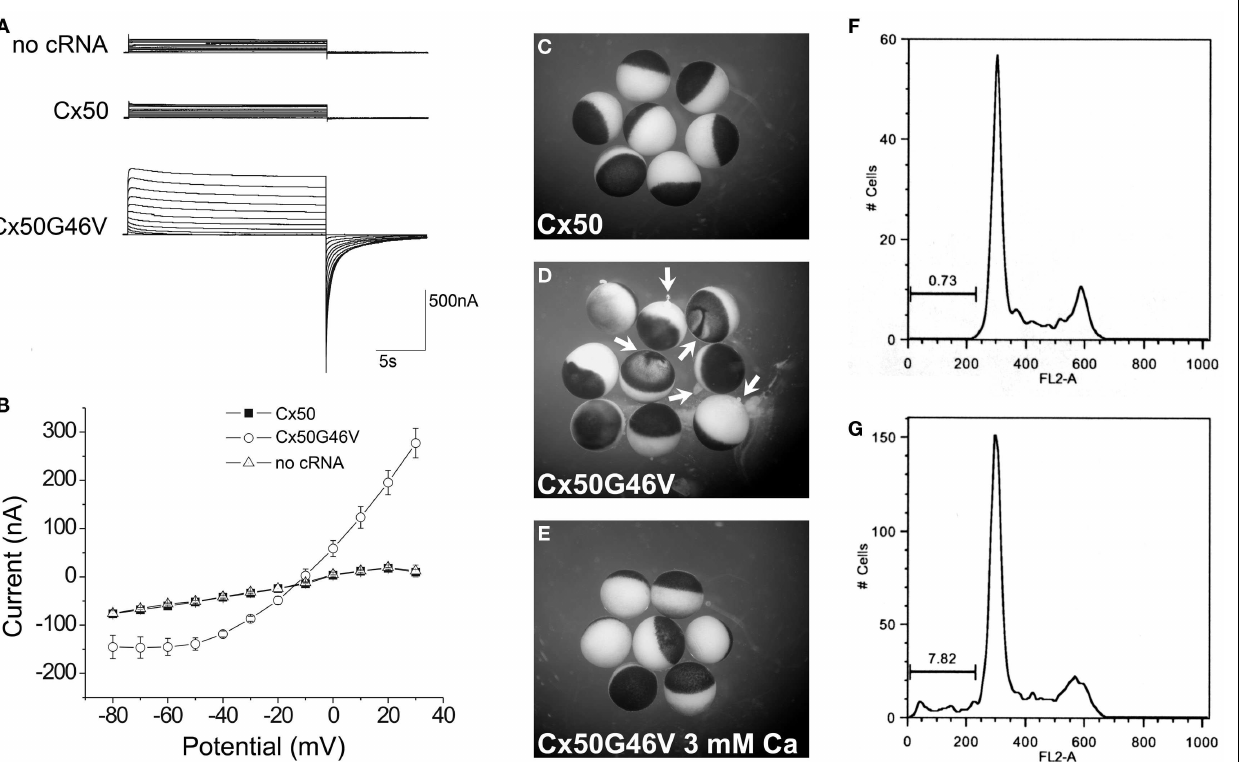
(arrows in D) when incubated in modified Barth’s solution containing 1mM Ca 2 + (D) while oocytes injected with Cx50 cRNA showed no apparent detrimental changes when studied under identical conditions (C) .The rate of cell death of the Cx50G46V cRNA-injected oocytes was significantly reduced by increasing the external calcium concentration from 1 to 3mM (E) . (F,G) . Graphs show the results of cell cycle analysis of propidium iodide-stained HeLa cells induced to express wild type Cx50 (F) or Cx50G46V (G) .This analysis revealed a substantial population of cells in the sub-G1 fraction, a marker for apoptosis, in cells expressing Cx50G46V but not in cells expressing Cx50 implying that expression of this mutant increased the proportion of apoptotic cells. Reproduced and adapted from Minogue et al.